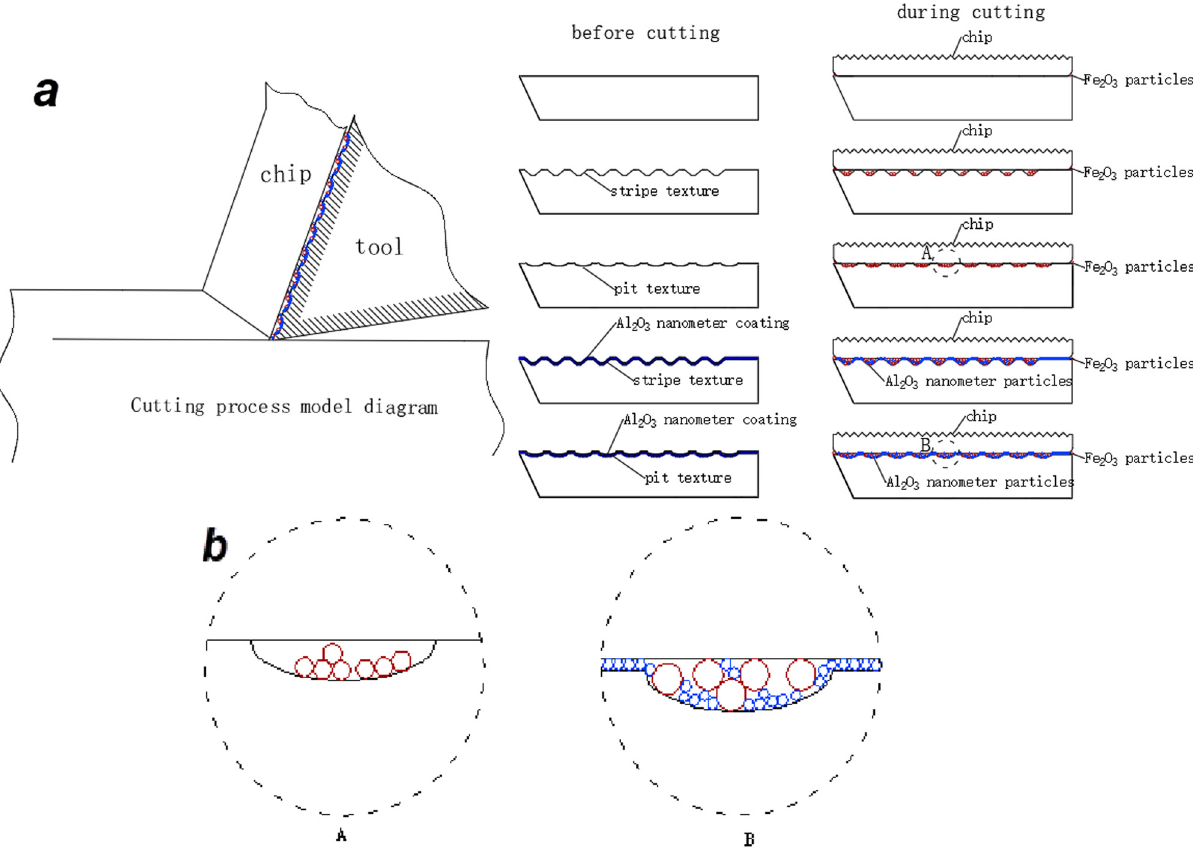
Figure 11: Anti - friction mechanism of nanometer - coated textured tools: ( a ) tool – chip interface contact of di ff erent tools, ( b ) magni fi ed view of point A and B in ( a )